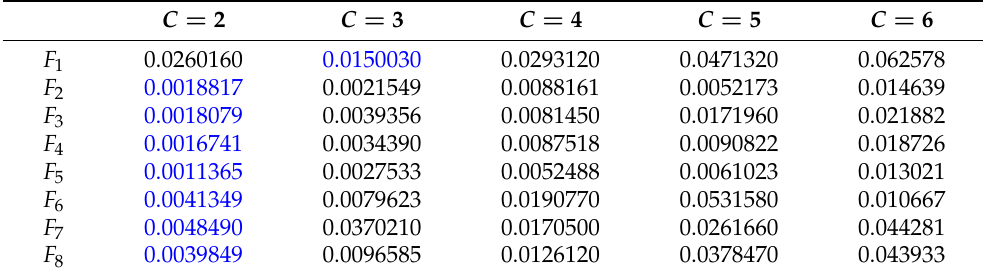
Table 5. Processing time in seconds using fuzzy c-means (best values in